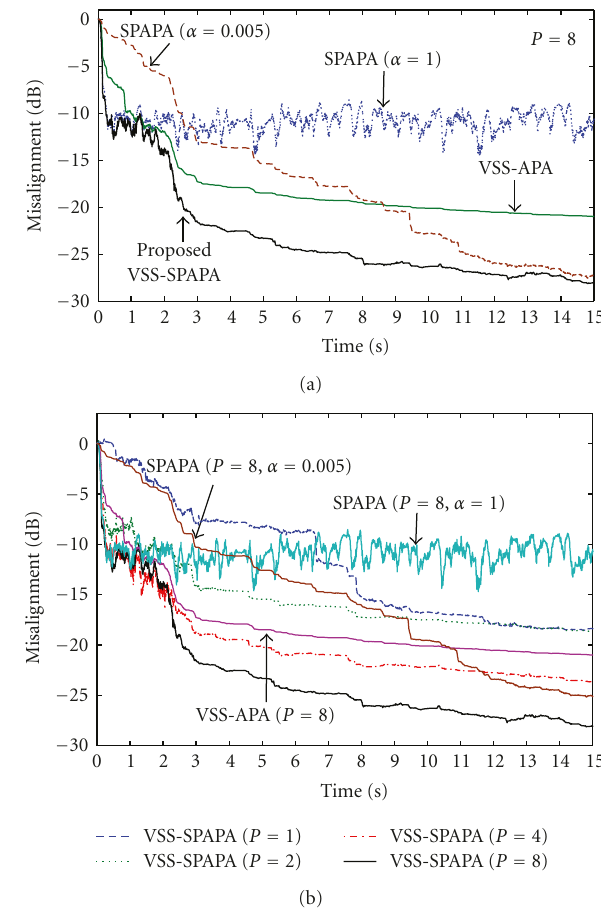
Figure 3: Misalignment of the algorithms with highly colored input generated by G ( z ). (a) P = 2. (b) Comparison with di ff erent projection order, P = 1, 2, 4, 8. SPAPA and VSS-APA are also illustrated.